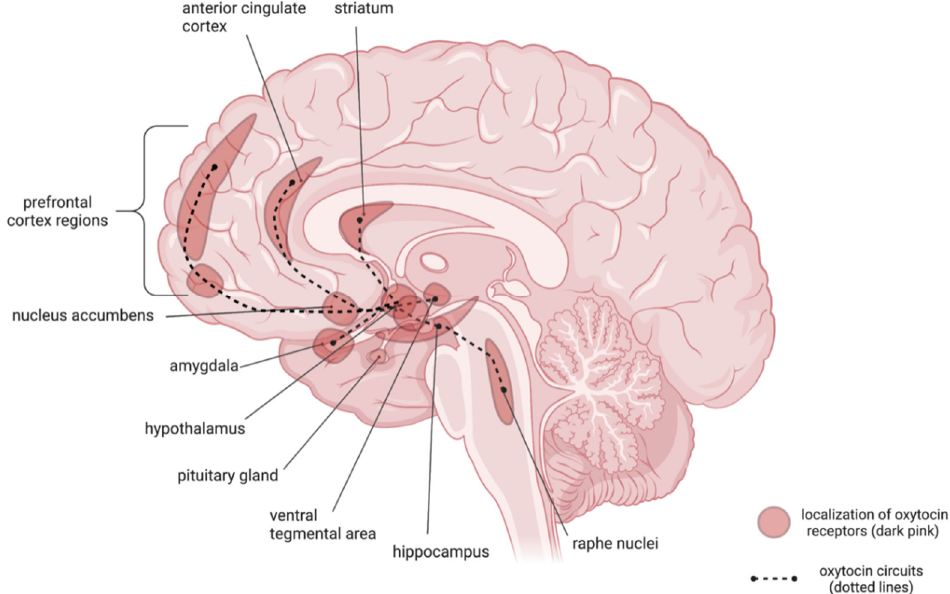
Figure 1. Localization of oxytocin receptors (dark pink) and oxytocin circuits (dotted lines) (created with BioRender.com, accessed on 18 June 2022).